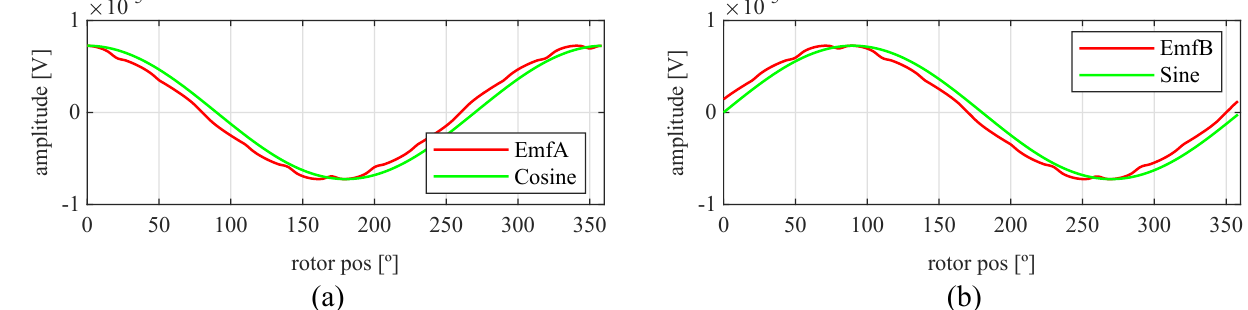
22 mW, and the weight was 33 g.